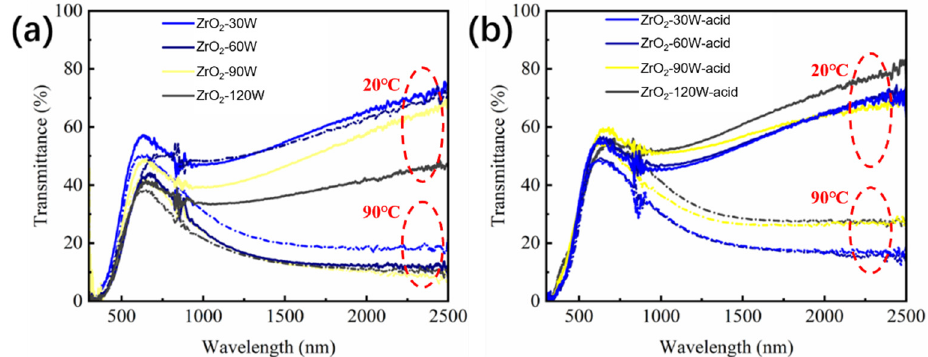
Figure 4. The transmittance of ( a ) samples ZrO 2 -30 W, ZrO 2 -60 W, ZrO 2 -90 W, and ZrO 2 -120 W, and ( b ) samples ZrO 2 -30 W-acid, ZrO 2 -60 W-acid, ZrO 2 -90 W-acid, and ZrO 2 -120 W-acid at 20 °C (line) and 90 °C (short point line), respectively. Table 2. The solar-modulation efficiency ( ∆ T sol ) and visible transmittance ( T lum ) of the obtained films. Sputtering Power